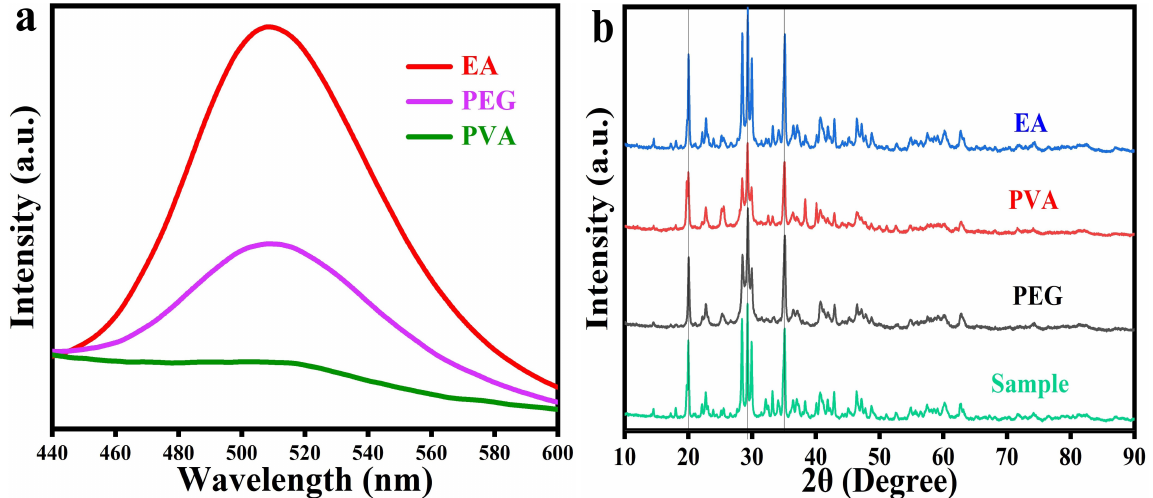
Figure 12. ( a ) Emission spectra of phosphors with different solvents ( λ em = 365 nm), ( b ) XRD patterns of samples with different